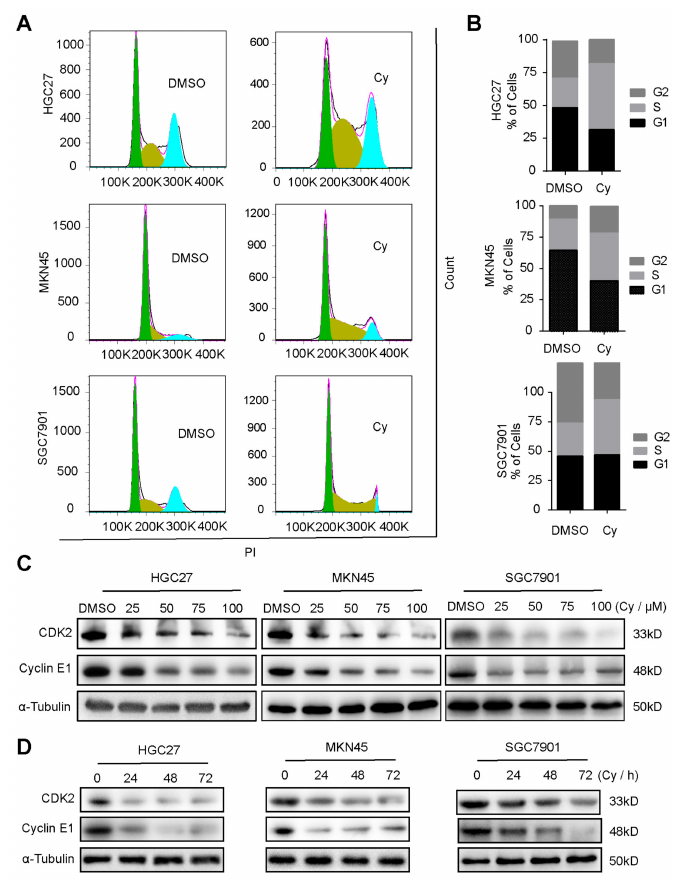
Figure 2. Cynaroside causes cell cycle arrest at S phase. ( A ) After Cy treatment of gastric cancer cells for 48 h, the cell cycle was detected by flow cytometry, and DMSO was used as a control. ( B ) The percentage of results of each cell cycle was statistically drawn about ( A ). ( C ) Cyclin E2 and CDK2 protein expression levels of cells treated with different concentrations of Cy for 48 h; α -Tubulin was used as control. ( D ) The expression of CDK2 and CyclinE2 in gastric cancer cells exposed to 50 µ M Cy for different times: 0, 24, 48 and 72 h. α -Tubulin was used as a